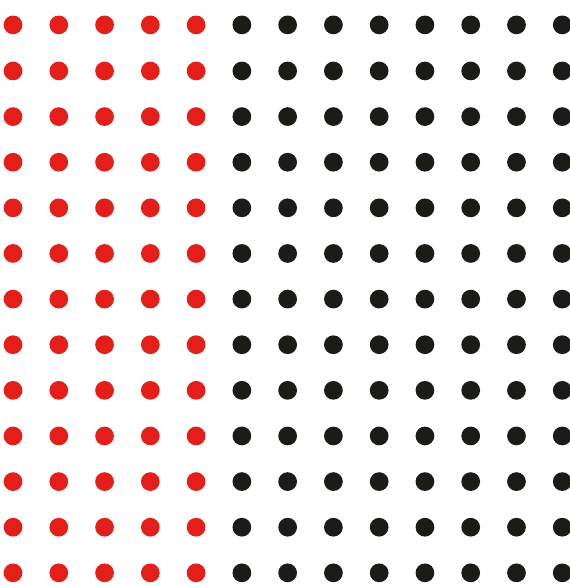
Figure 35: Schematic diagram of uplifted nodes under the concen- trated mass located on the fourth floor (65 nodes uplifted and the maximum uplift area ratio is 33.3%).